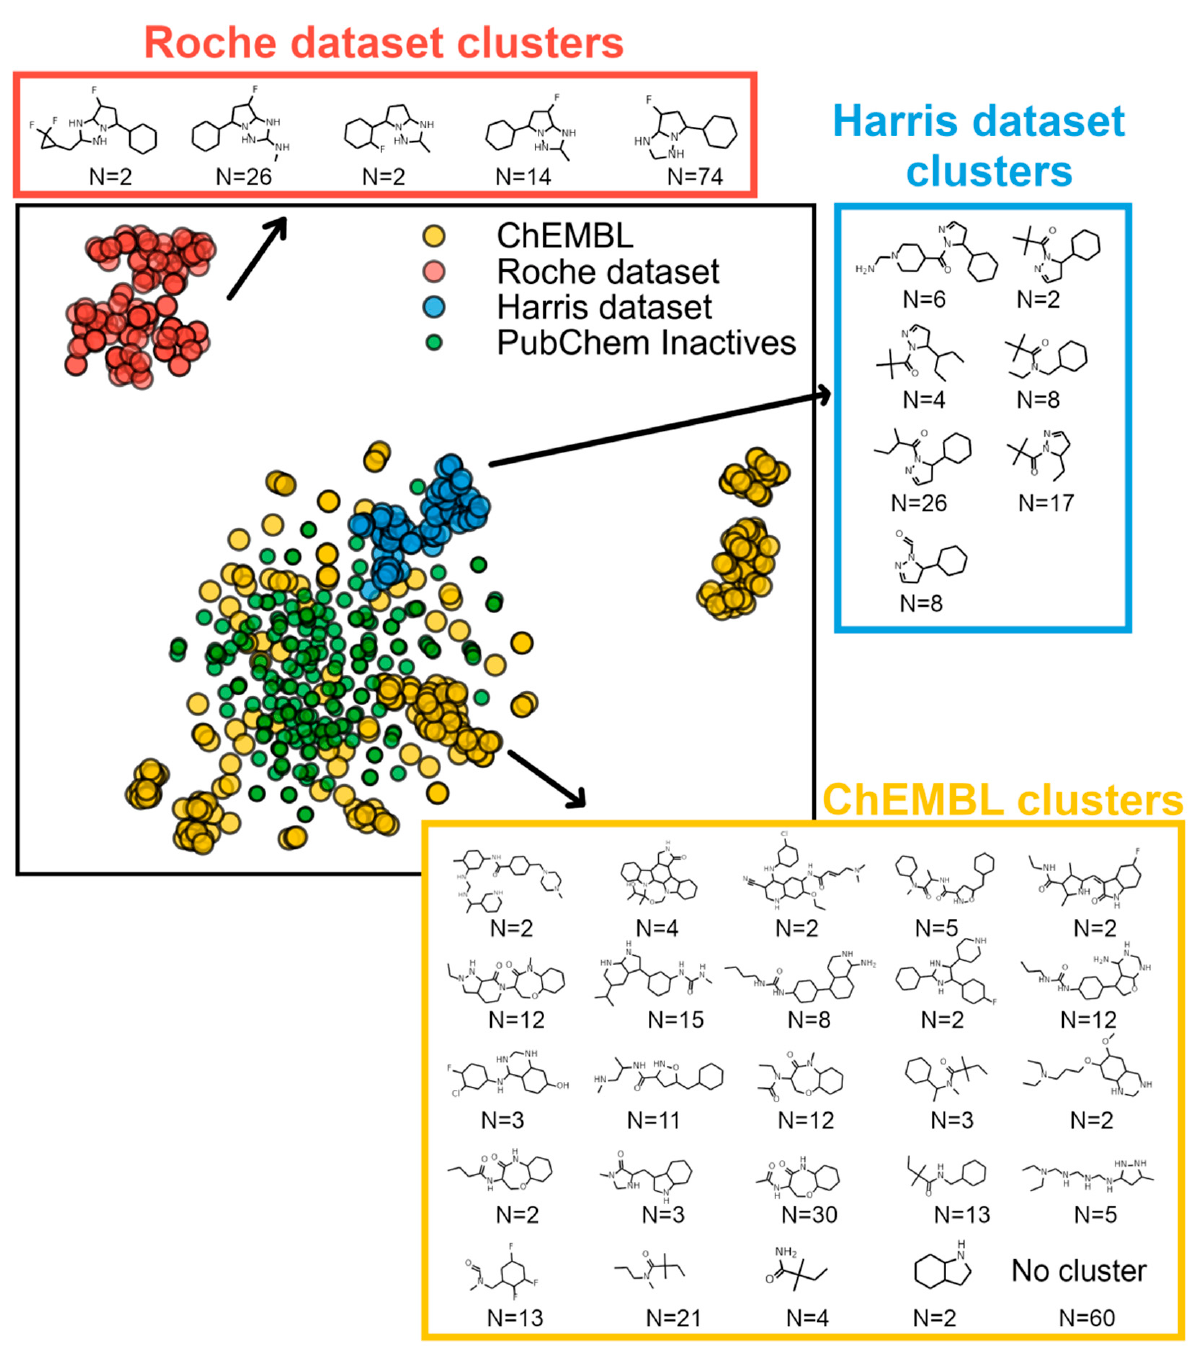
Figure 5. Chemical space distribution of RIPK1 inhibitors, produced using t-SNE over 1024-bit Morgan fingerprints. Relevant scaffold structures from each dataset were identified by hierarchical clustering, followed by maximum common substructure (MCS) decomposition.